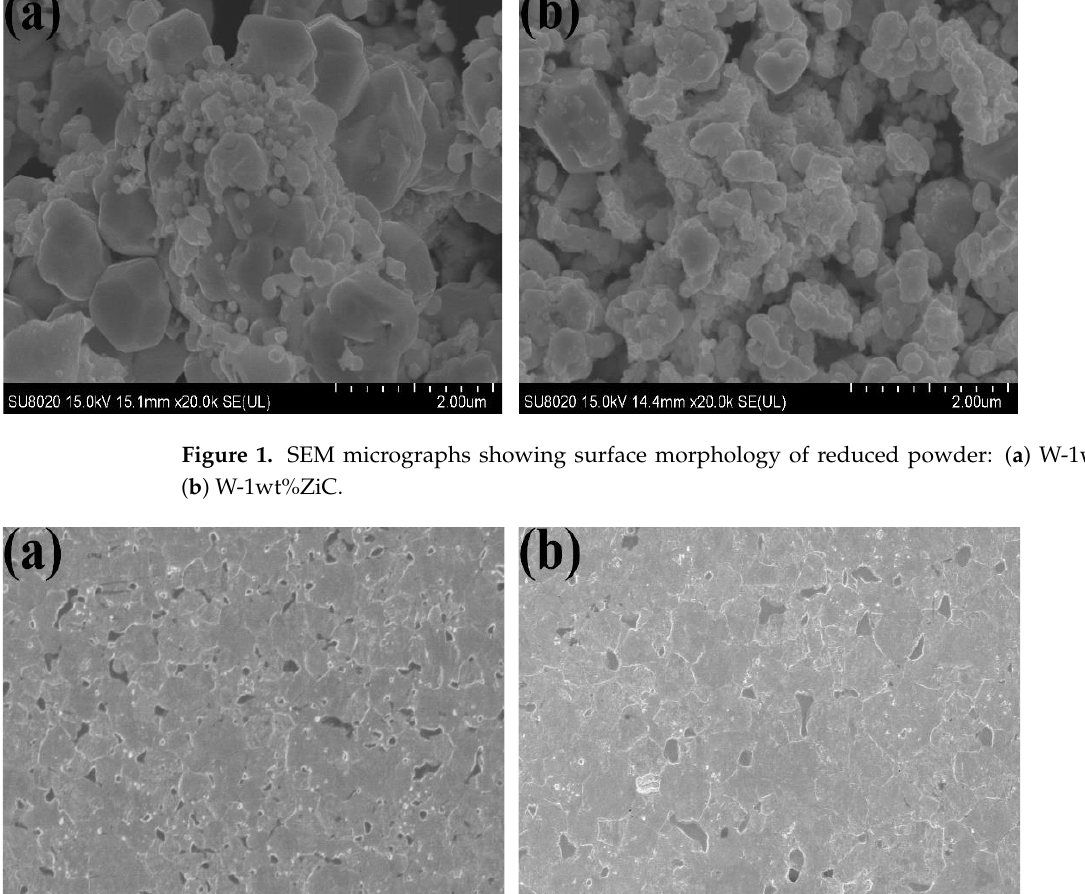
Figure 1. SEM micrographs showing surface morphology of reduced powder: ( a ) W-1wt%TiC, ( b ) W-1wt%ZiC.